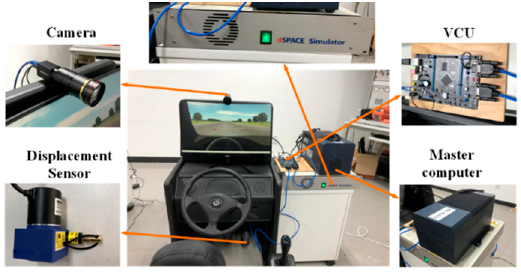
Figure 10. HIL platform. Table 3. Road geometry characteristics.